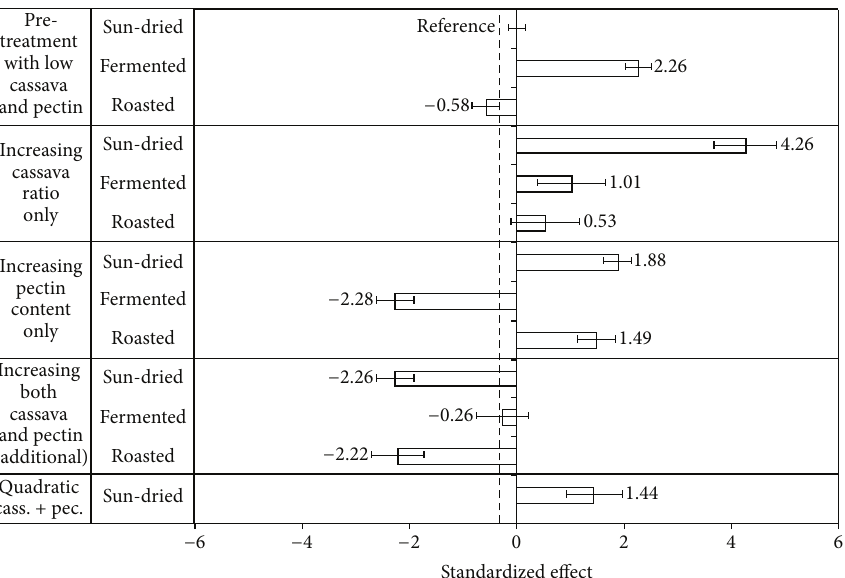
Figure 2: Modified Pareto chart showing the relative effects of pretreatments, flour composition factors, and the interaction of these on bread firmness (N) according to the regression model ( 𝑅 2 = 0.95 ). Bread made with sun-dried flour with low cassava and low HM-pectin contents was set as reference bread. The firmness of wheat bread is indicated by a dotted line. Effects with error bars not including point 0 are statistically significant at 95% confidence level.